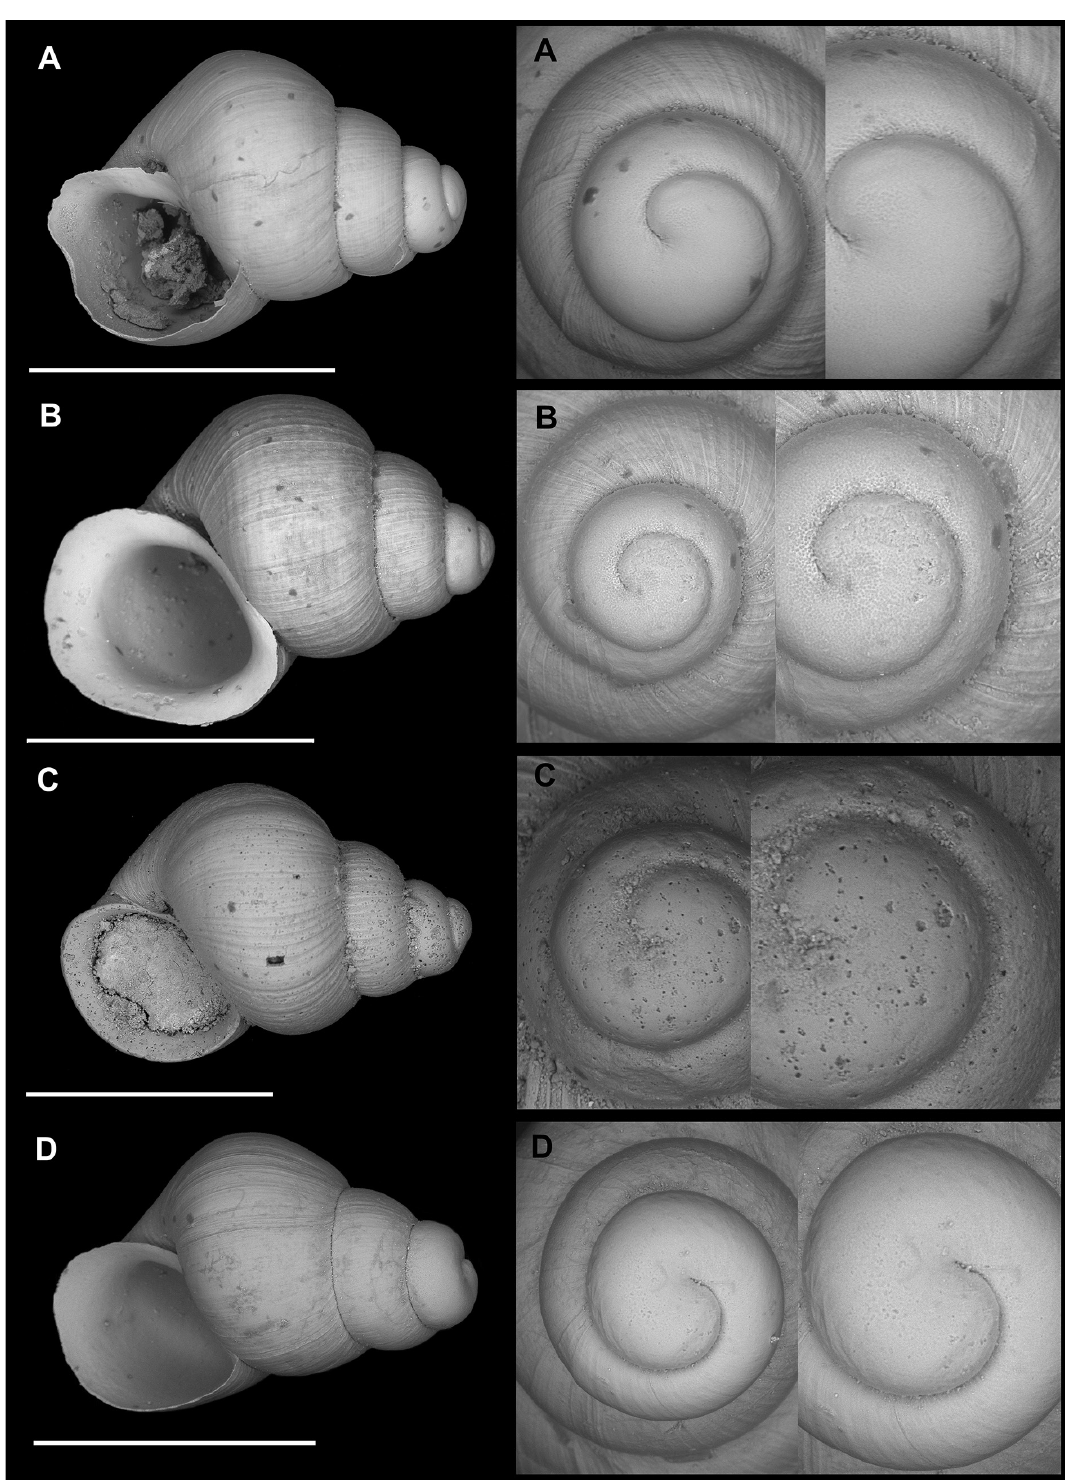
Fig. 15. A . Travunijana robusta (Schütt, 1959), Trebinje, Izvor Tučevac, SBMNH 626406. B . Travunijana robusta (Schütt, 1959), Trebinje, Vrelo Vruljak 1, SBMNH 625919. C . Travunijana robusta asculpta (Schütt, 1972), Croatia, Dubrovnik, Komolac, Izvor Ombla, SBMNH 625896. D . Travunijana gloeri sp. nov., Bjeljani, Dabarsko Polje, Vrelo Vrijeka, paratype SBMNH 632722. Scale bars = 1mm. (SEM SBMNH Vanessa